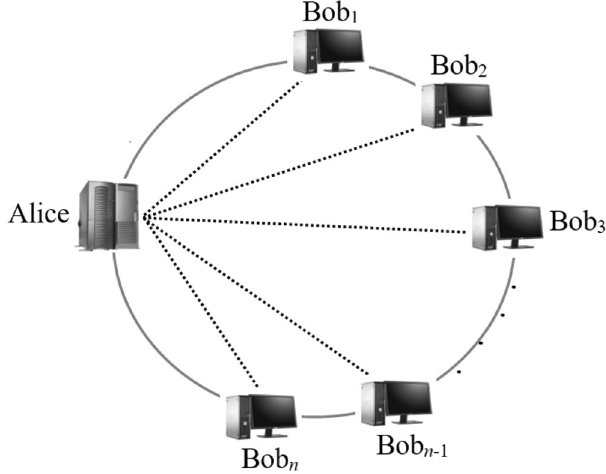
Figure 1. A system model of